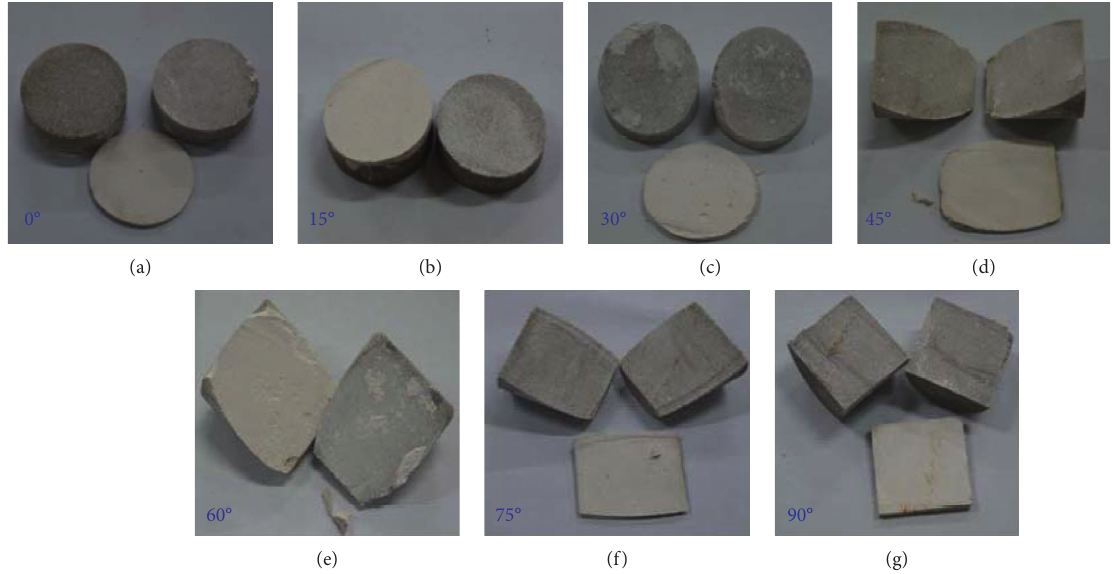
Figure 4: The failure modes of specimens with various joint angles under the strain rate of 85s − 1 .